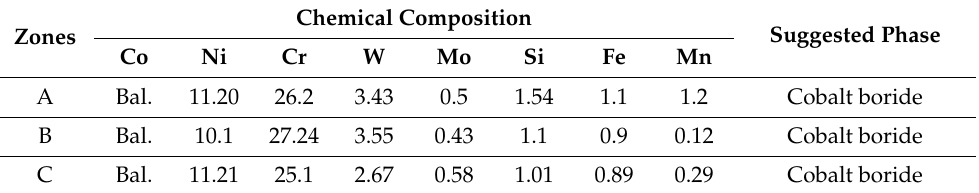
Figure 19. SEM micrograph of fine and needle-like precipitations on the side of the X-45 with the 1100 °C/10 min bonding condition: (A) Fine Cobalt Boride, (B) Continuous needle-like and (C) Discontinuous needle-like. Table 8. EDX analysis of various phases indicated in Figure 19 (wt. %).